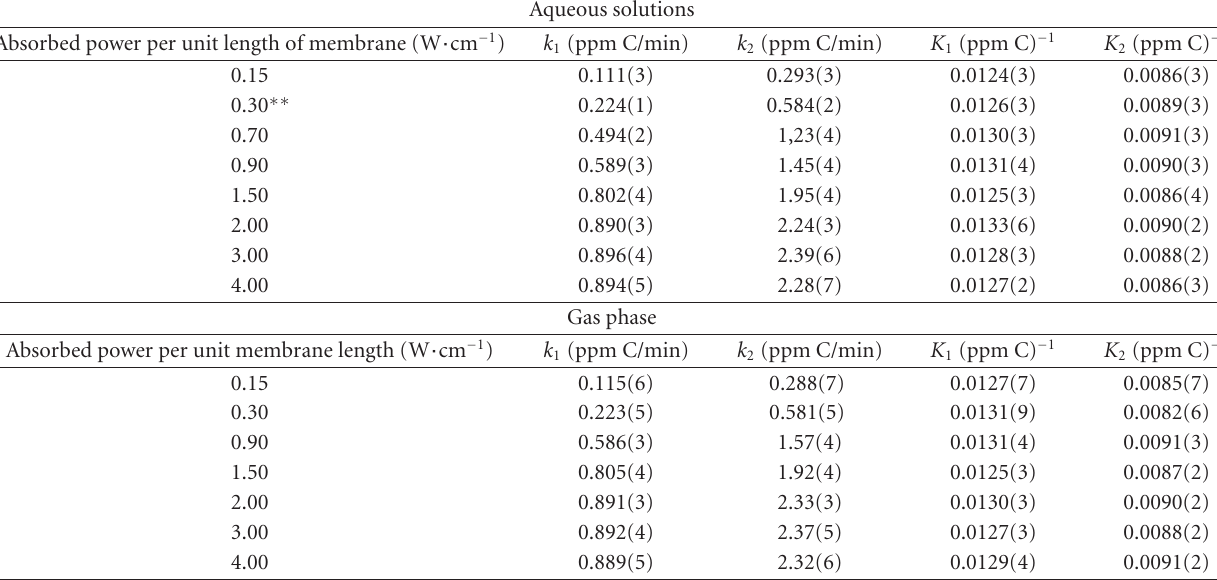
Table 1: Parameters ∗ , k 1 and K 1 , k 2 and K 2 , able to fit the whole photomineralization curve, following Scheme (2), at various values of absorbed power per unit length of membrane expressed inW · cm − 1 . They were obtained by the optimization of kinetic curves, by using the set of di ff erential equations corresponding to kinetic model of Scheme (2). All the parameters are expressed in ppm of carbon (mass of C/volume, mg/L) and refer to the photodegradation of methane in gaseous phase, and in aqueous solutions, in the presence of stoichiometric hydrogen peroxide (for the aqueous solutions) or of dioxygen of air (for the gas-phase experiments), as oxygen donors (treated volume of the gas phase or of the aqueous solutions 4.00 L; membrane length 100 . 0 ± 0 . 5 cm; ratio between overall reaction volume and membrane length 160 ± 6 cm 3 /cm 2 ; PHOTOPER M (cid:2) BIT/313 membranes immobilizing 30 ± 3 wt.% TiO 2 , in the absence of any